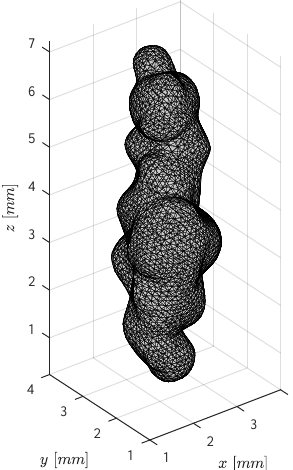
Figure 26. Numerically generated shrinkage